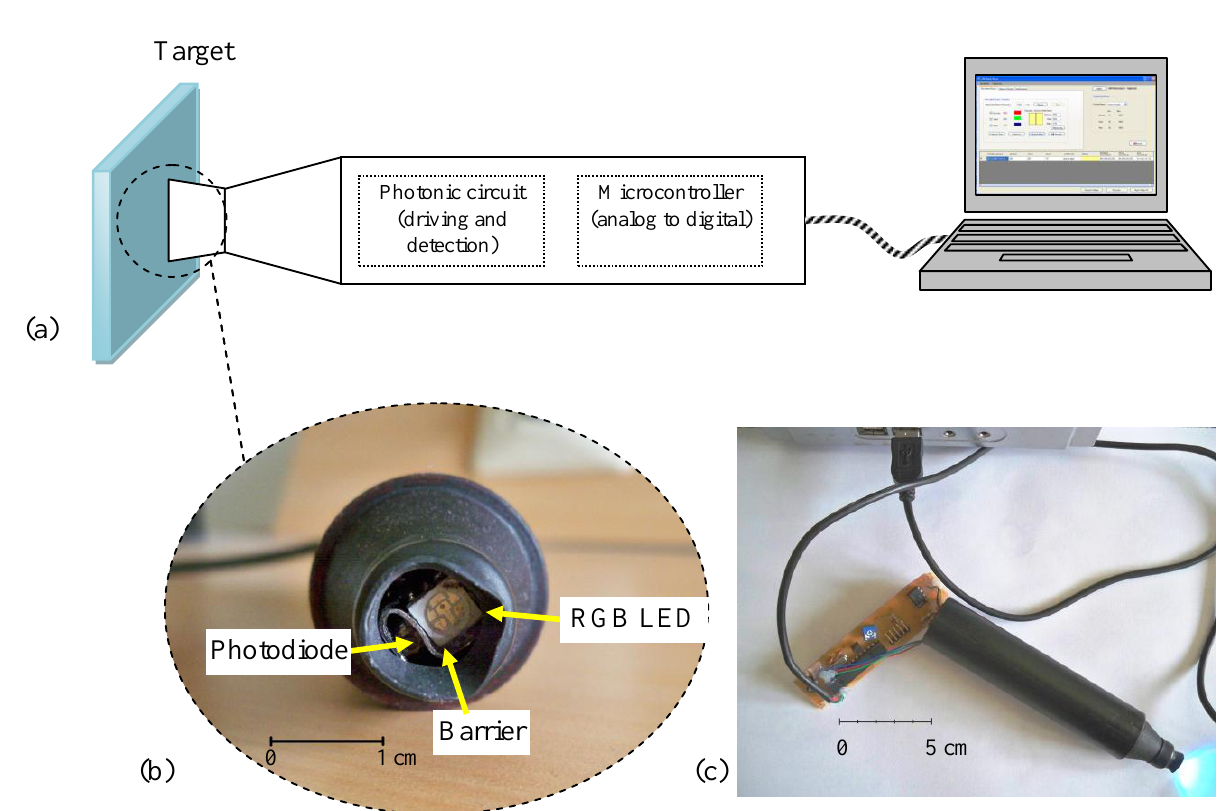
Figure 2. (a) Schematic illustration of RGB LED based color. (b) Photo of sensor tip. (c) Sensor probe connected with